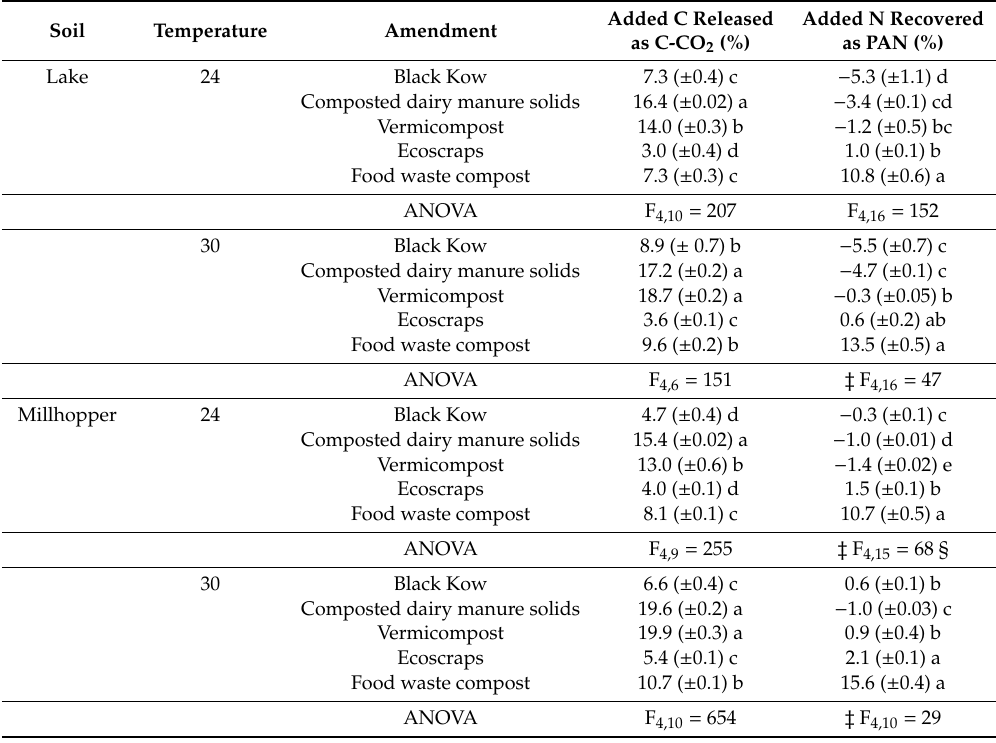
Table 3. Mean ( ± standard error) of multiple measurements (one measurement per jar, two to five total jars per treatment) for percentage of TC inputs emitted as C-CO 2 and percentage of TN inputs recovered as PAN (NO 3 + NH 4 ). ANOVAs were performed on mean concentrations between treatments. Di ff erent letters amongst amendments within each soil x temperature combination represent significant di ff erences based on Tukey’s HSD ( α = 0.05). Data in which residuals had a significant Shapiro–Wilks statistic are indicated